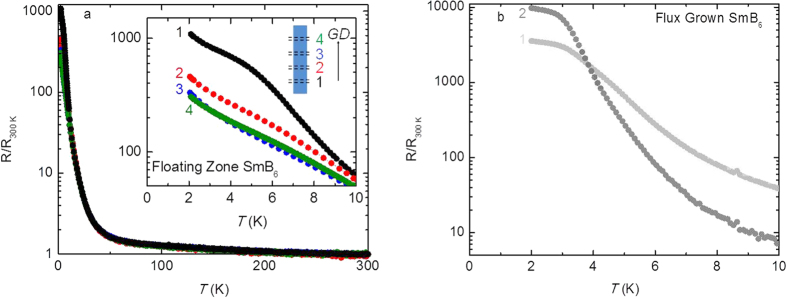
(a) Resistance (R) normalized by the room temperature resistance values (R300 K) versus temperature (T) for the FZ cuts 1–4. The inset highlights the trend in normalized resistance from 0 to 10 K showing that the magnitude of R/R300 K and the degree of plateauing decreases from 1 to 4. (b) Resistance (R) normalized by the room temperature resistance values (R300 K) versus temperature (T) for two FG SmB6 crystals arbitrarily designated “1” and “2”. While the magnitudes of the R/R300 K data points differ at low temperatures, a resistance plateau is observed for these crystals and other FG SmB6 crystals from this growth. These low temperature data resemble closely other flux samples reported in literature, carbon doped SmB6
FZ crystals, and cut 1 seen in a).